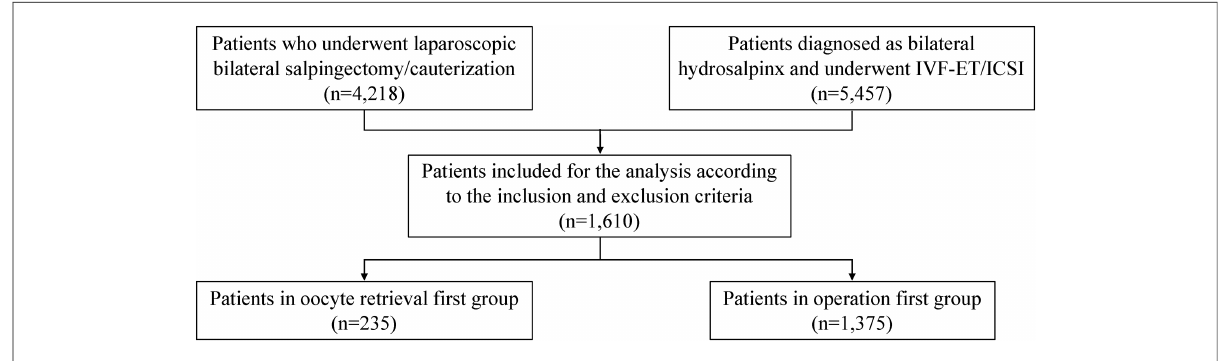
FIGURE 1 Flowchart illustrating the inclusion of cases in the study.